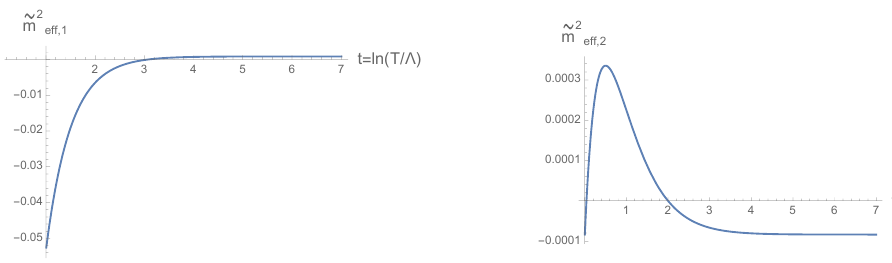
Figure 15. Plots of the rescaled effective masses (squared) against t = ln( T/ Λ) for r = 0 . 1 , θ = 2 . 1 , λ = 0 . 001 , c 1 = c 2 = − 0 . 2 : a pair of phase transitions occurs in the second